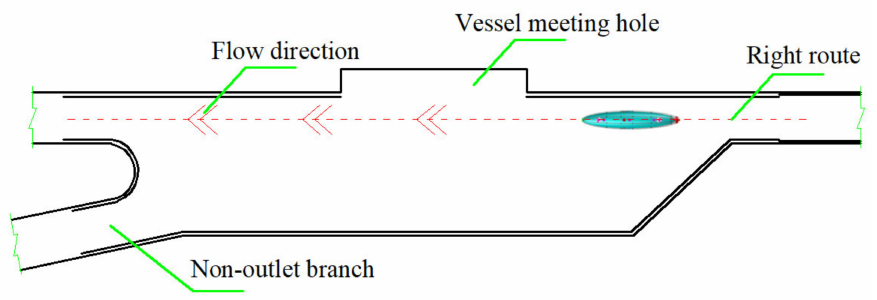
Figure 4. Schematic diagram of obstacle